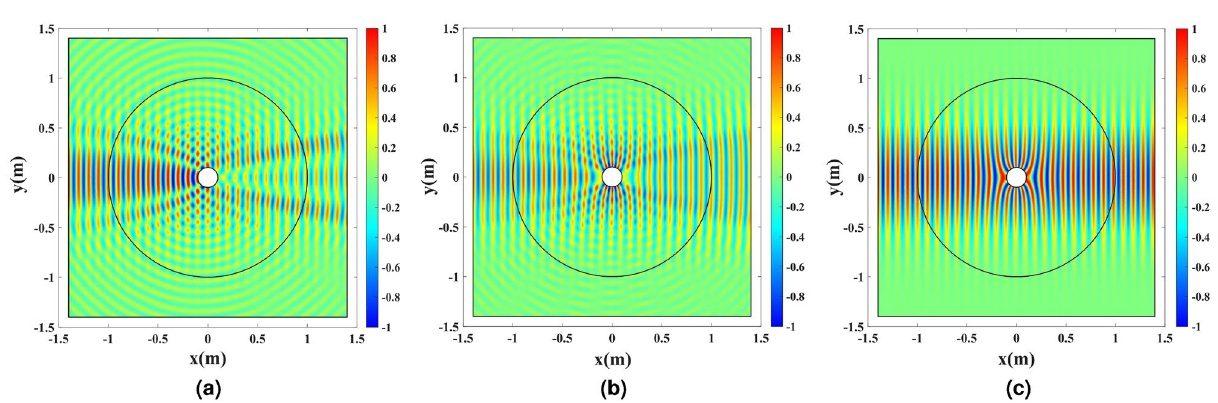
Figure 7. The cylindrical wire enclosed by the refractive index profile depicted in Fig. 5 and excited by the uniform electric current density J z at 3 GHz. ( a ) The amplitude of E z , and ( b ) the normalized far-field pattern with and without the dielectric shell.